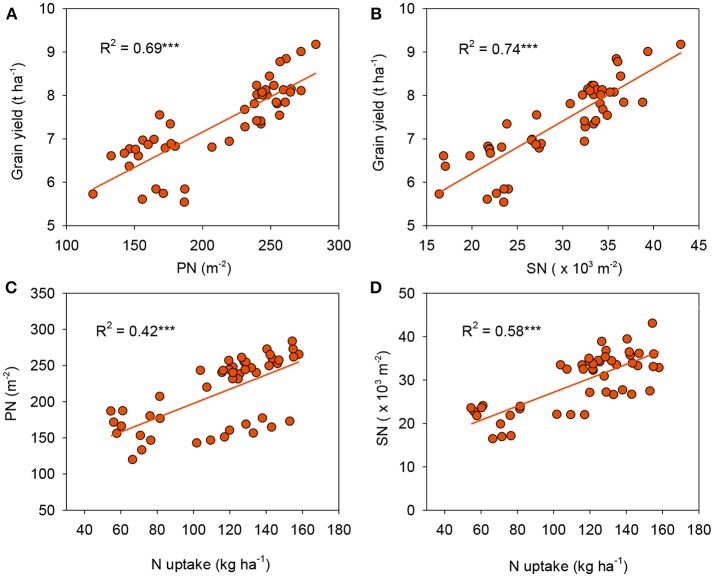
Linear relationships of grain yield with panicle number [PN, (A)] and spikelet number [SN, (B)], and PN (C) and SN (D) with N uptake. ***p < 0.001.